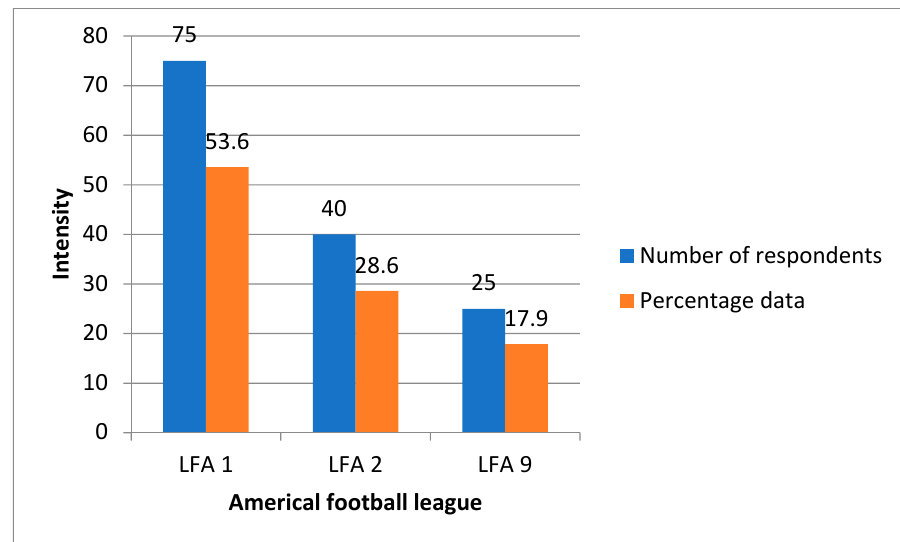
Figure 1. Division of the surveyed players according to the represented LFA game level.